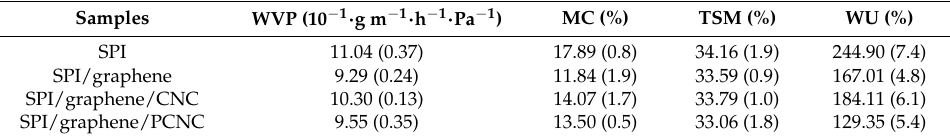
Table 3. Water vapor permeability (WVP), moisture content (MC), total soluble matter (TSM), and water uptake (WU) of SPI film and SPI-based films modified with graphene, CNC, and